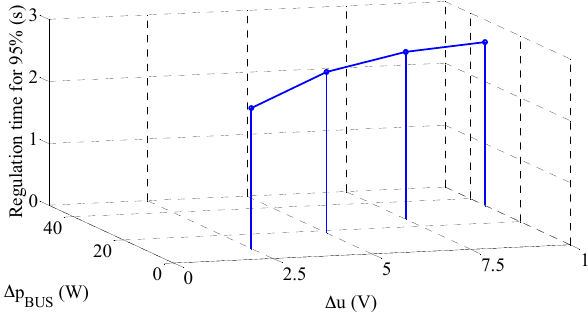
Figure 4. Relationship between voltage step input, power response and regulation time.